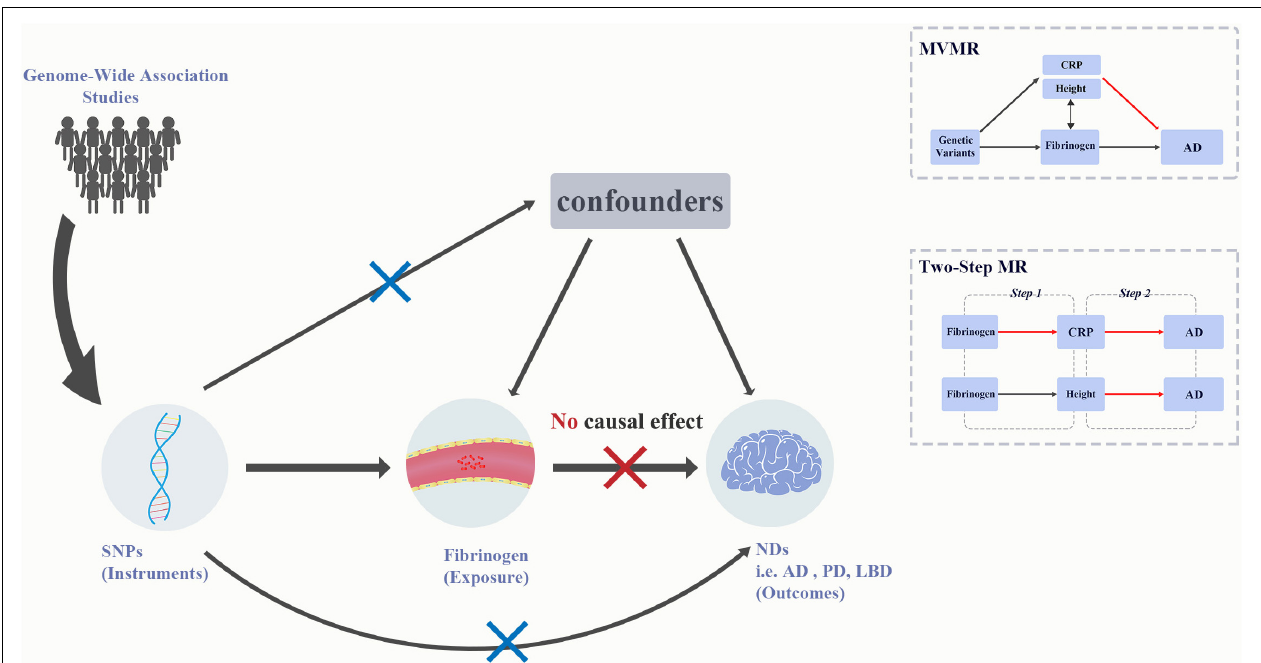
FIGURE 1 | Graphical abstract for current univariable MR and MVMR analyses. MR analysis is based on the three assumptions: (1) IVs should be associated with the exposure, (2) any association between the IVs and the outcome must come via the IVs association of IVs with the exposure, and (3) IVs should be independent of any measured and unmeasured confounders. The SNPs used in MR acted as IVs were obtained from large-scale genome-wide association studies. Results for univariable MR did not support the causal effect of fibrinogen and γ -fibrinogen on AD, PD, and LBD, whereas the results for MVMR showed the association between height and AD. AD, Alzheimer’s disease; IVs, instrumental variables; LBD, dementia with Lewy bodies; MR, Mendelian randomization; MVMR, multivariable Mendelian randomization; NDs, Neurodegenerative diseases; PD, Parkinson’s